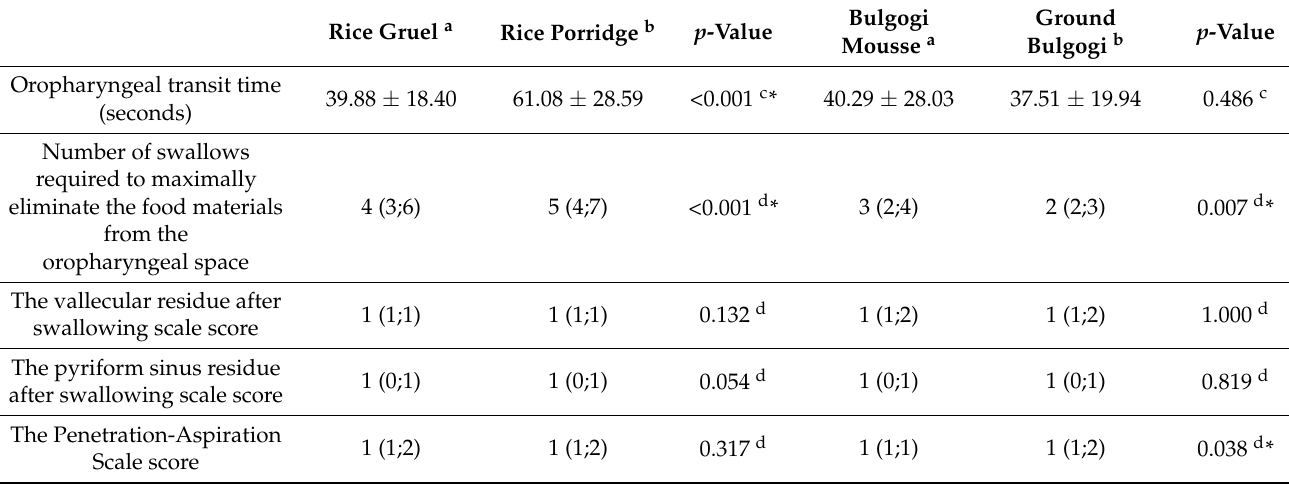
Table 4. Comparison of outcome